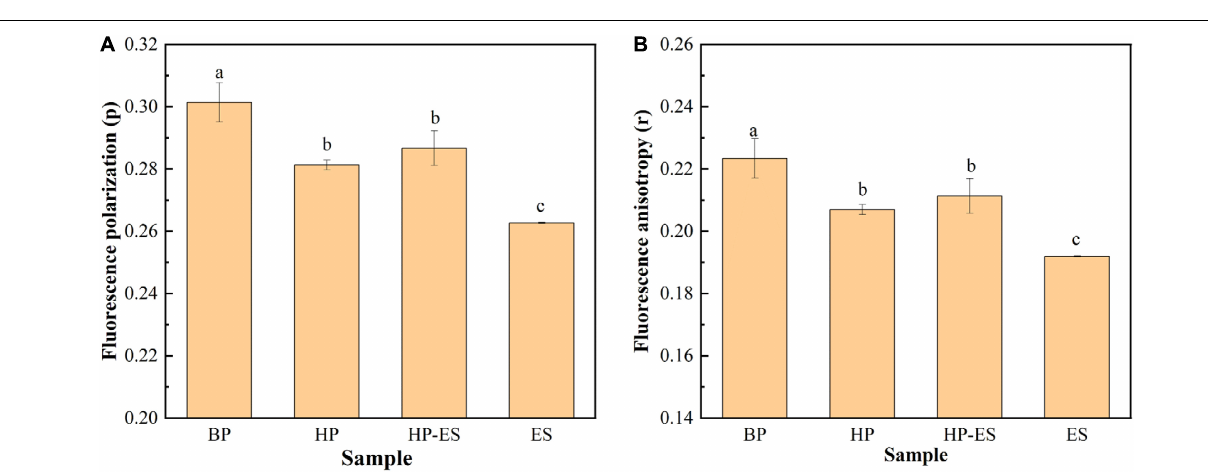
FIGURE 4 | Changes in membrane fluidity of T. halophilus under ethanol stress. (A) fluorescence polarization ( p ); (B) fluorescence anisotropy ( r ). BP (before preadaptation): cells harvested at mid-exponential growth phase without any treatment; HP (heat preadaptation): cells harvested at mid-exponential growth phase were preadapted at 45 ◦ C for 1.5 h; HP-ES (heat preadaptation-ethanol stress): cells were preadapted at 45 ◦ C for 1.5 h and then subjected to 10% ethanol stress for 2.5 h; ES (ethanol stress): cells subjected to 10% ethanol stress for 2.5 h without heat preadaptation. Error bars indicate SD ( n = 3). Significant differences among the groups are marked with different letters ( p <